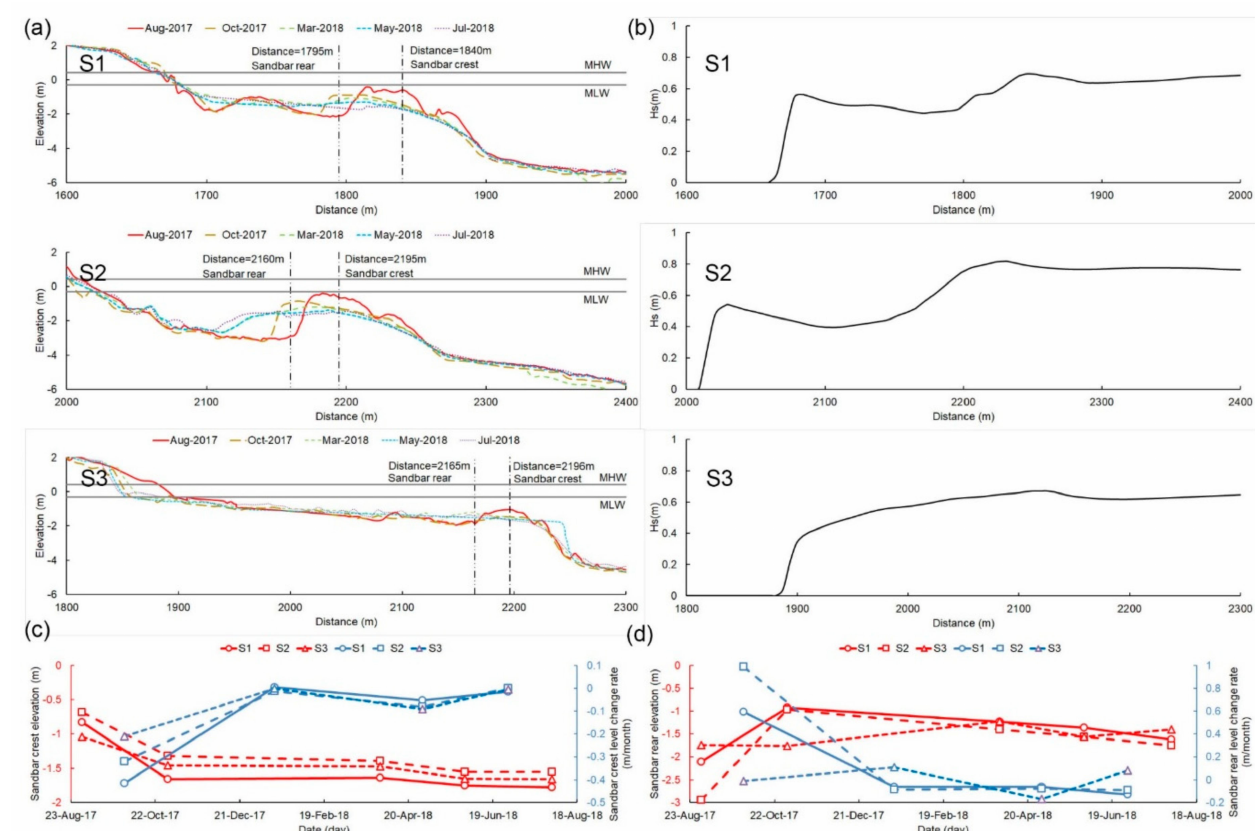
Figure 6. ( a ) Measured profile elevations and ( b ) accordingly significant wave height from model results along P7, P12, P17 under the typical strong wave condition in September 2017 shortly after the beach nourishment; ( c ) sandbar crest elevation and its change rate; ( d ) sandbar rear elevation and its change